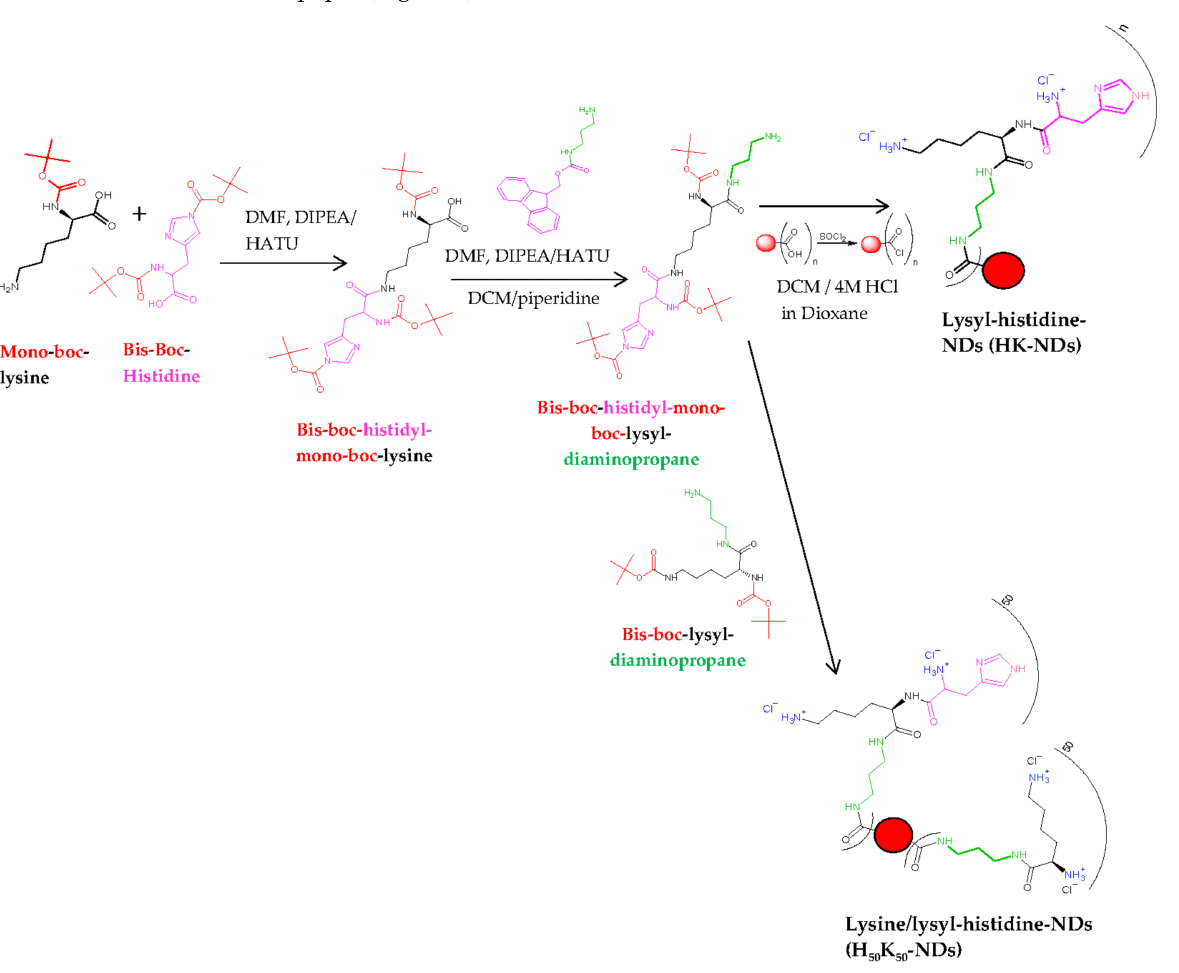
Figure 1. Schematic illustration to design lysyl-histidine-NDs (HK-NDs) and lysine/lysyl-histidine- NDs (H 50 K 50 -NDs). Final structures represent charged states of HK-NDs and H 50 K 50 -NDs at physio- logical